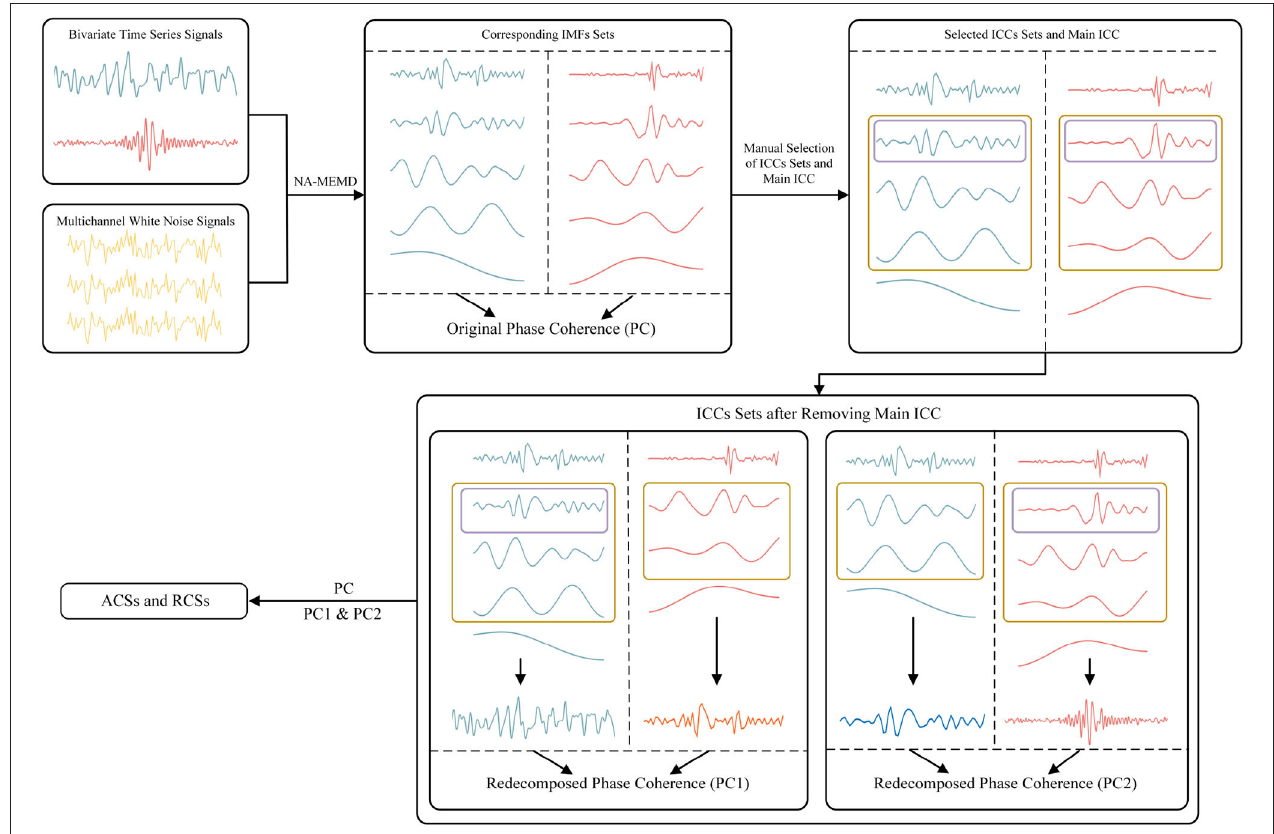
FIGURE 1 | Basic workflow for NA-MEMD Causal